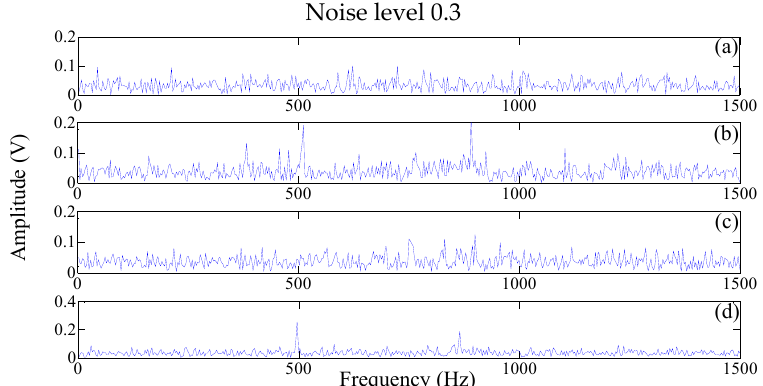
Figure 13. Examples of noised signals (from level 0.1 to 0.3) and their spectra of four health status patterns: ( a ) slight wear; ( b ) medium wear; ( c ) broken tooth; and ( d ) normal wear signals.